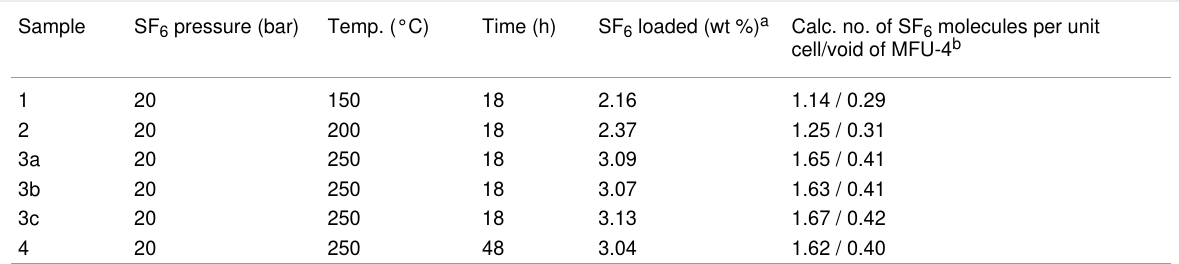
Table 1: SF 6 -loading into MFU-4 under various conditions. Sample